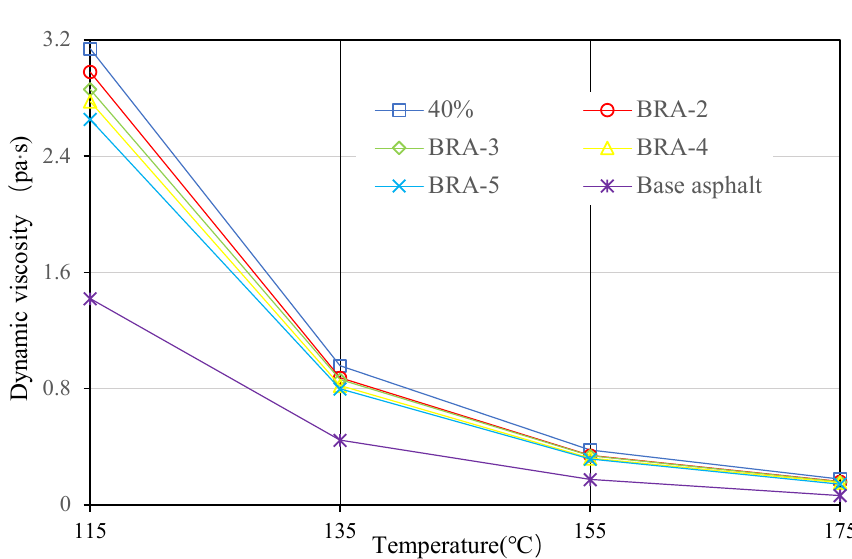
Figure 11. Viscosity of BRA-MA with 30% BRA.